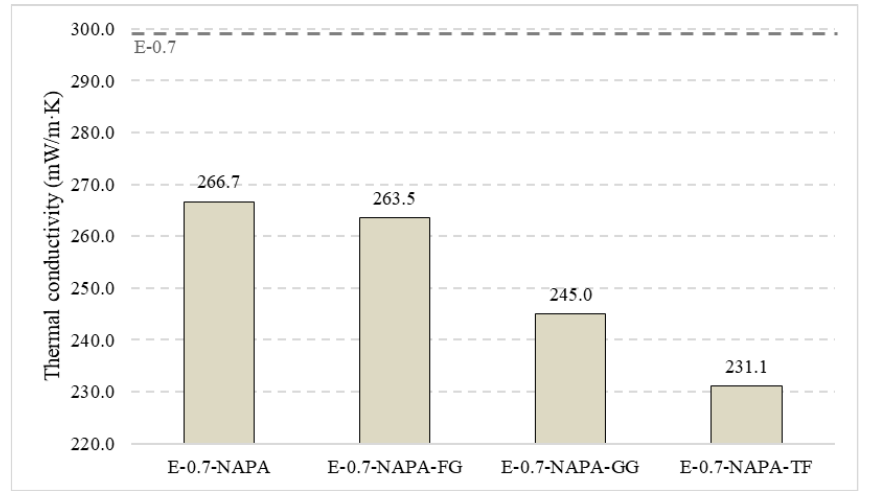
Figure 18. Guarded hot plate test thermal conductivity results (mW/(m·K)).